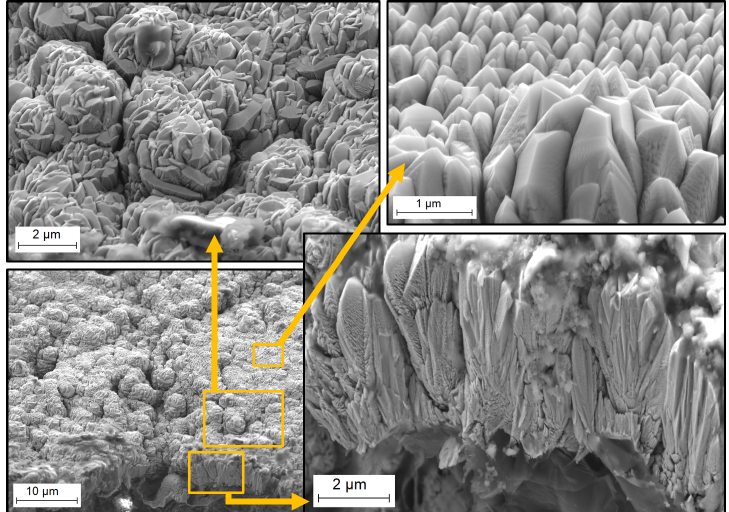
Figure 26. SEM observations of a Mo-coated graphite sample produced with DCMS. The fracture surface ( bottom ) and the coating surface ( top ) are shown.